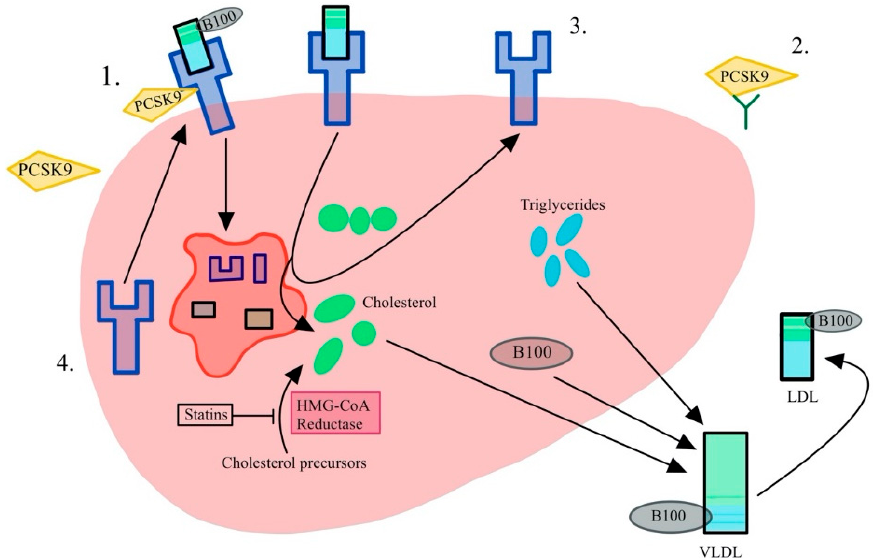
Figure 5. The mechanism of action of PCSK9 inhibition in the hepatocyte. (1) PCSK9 marks the LDL receptor for endocytosis and lysosomal degradation. (2) An anti-PCSK9 antibody prevents PCSK9 binding to the LDL-R. (3) The free LDL-R clears more LDL particles. (4) A decrease in intracellular cholesterol due to statins will upregulate LDL-Rs and subsequent clearance. HMG-CoA, β -hydroxy β -methylglutaryl-CoA; LDL, low-density lipoprotein; PCSK9, proprotein convertase subtilisin/kexin type 9; VLDL, very low-density